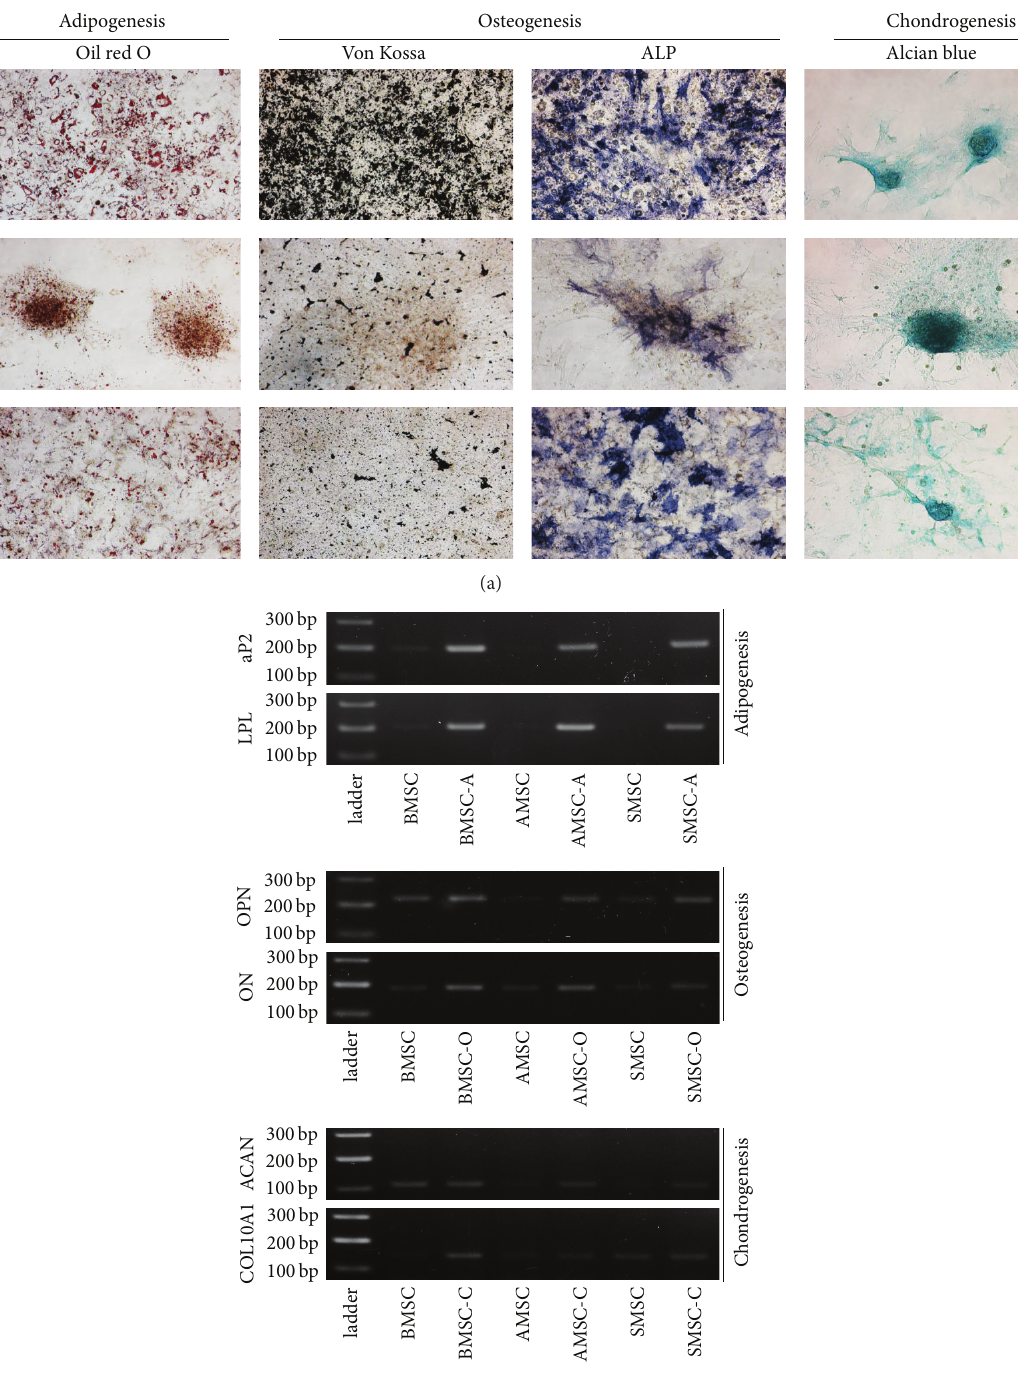
Figure 2: Confirmation of differentiation ability into various mesenchymal lineages. Three kinds of MSCs were differentiated into adipocytes, osteocytes, and chondrocytes for three weeks. (a) Cytochemical staining of each differentiated MSCs with Oil red O, Von Kossa, AP staining, and alcian blue. (b) Increased intensities of lineage specific gene expression before and after differentiation in each MSCs by RT-PCR. Lanes, which were displayed from the left to the right, showed 100bp or 200bp ladder, undifferentiated MSCs, and differentiated cells in numerical order of BMSCs, AMSCs, and SMSCs, respectively. AP2 : adipocyte fatty acid binding protein; LPL : lipoprotein lipase; OPN : osteopontin; ON : osteonectin; ACAN : aggrecan; COL10A1 : collagen, type X, alpha 1; BMSC-A, BMSC-O, and BMSC-C: differentiated BMSC into adipocytes, osteoblasts, and chondrocytes, respectively; AMSC-A, AMSC-O, and AMSC-C: differentiated AMSC into adipocytes, osteoblasts, and chondrocytes, respectively; SMSC-A, SMSC-O, and SMSC-C: differentiated SMSC into adipocytes, osteoblasts, and chondrocytes, respectively. Magnification ×